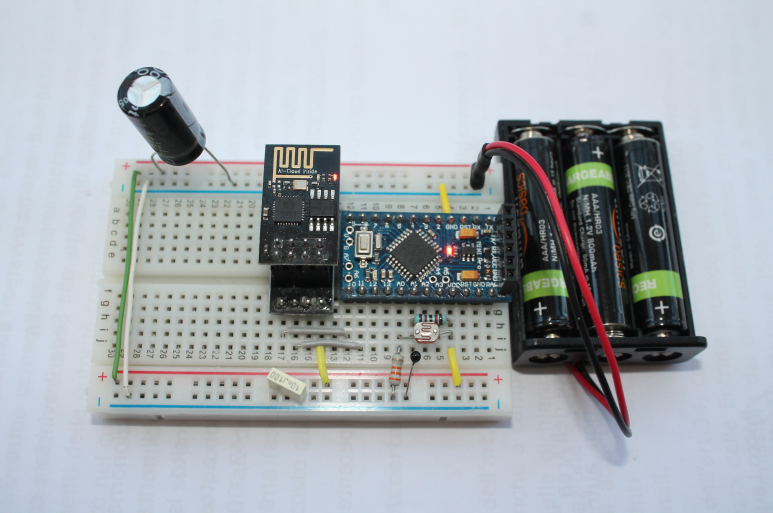
Figure 4. An early prototype of the sensor, mounted on a